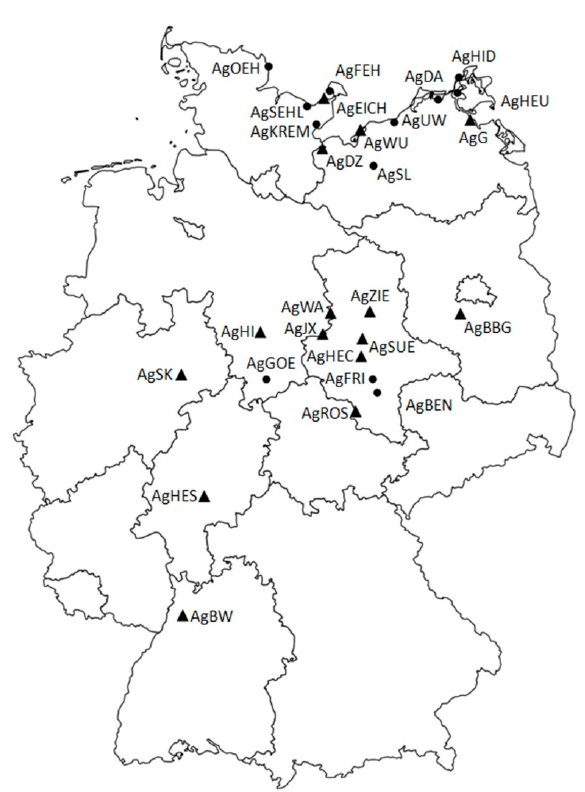
Figure 2. Map showing the locations of the 27 occurrences. A black triangle marks the 15 Most Appropriate Wild Populations (MAWP) while a black dot marks the remaining 12 occurrences. The location names are given in Table 1.